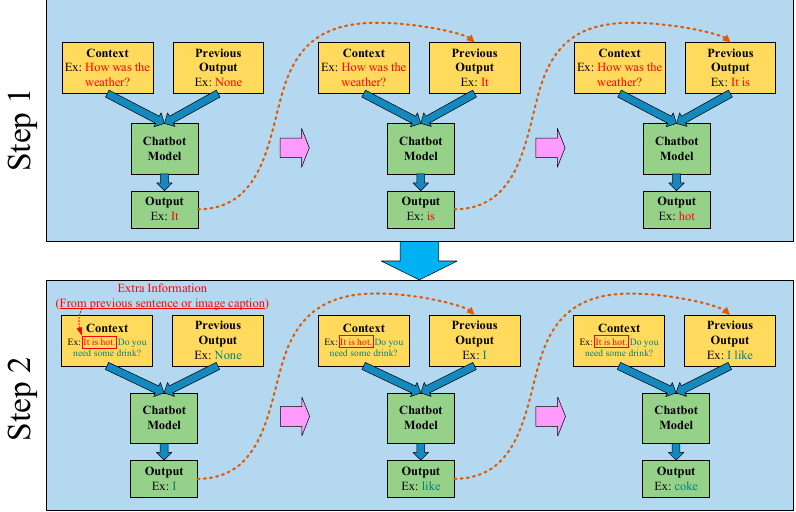
Figure 6. The workflow of the designed chatbot model.